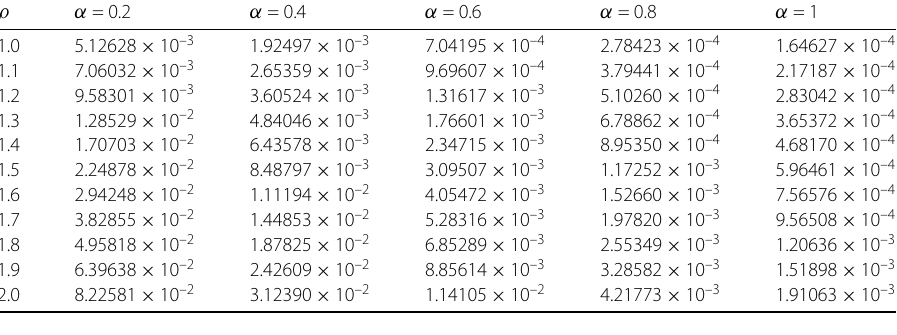
Figure 1 Exact and numerical solutions for m = 64, ρ = 1.6, and α =